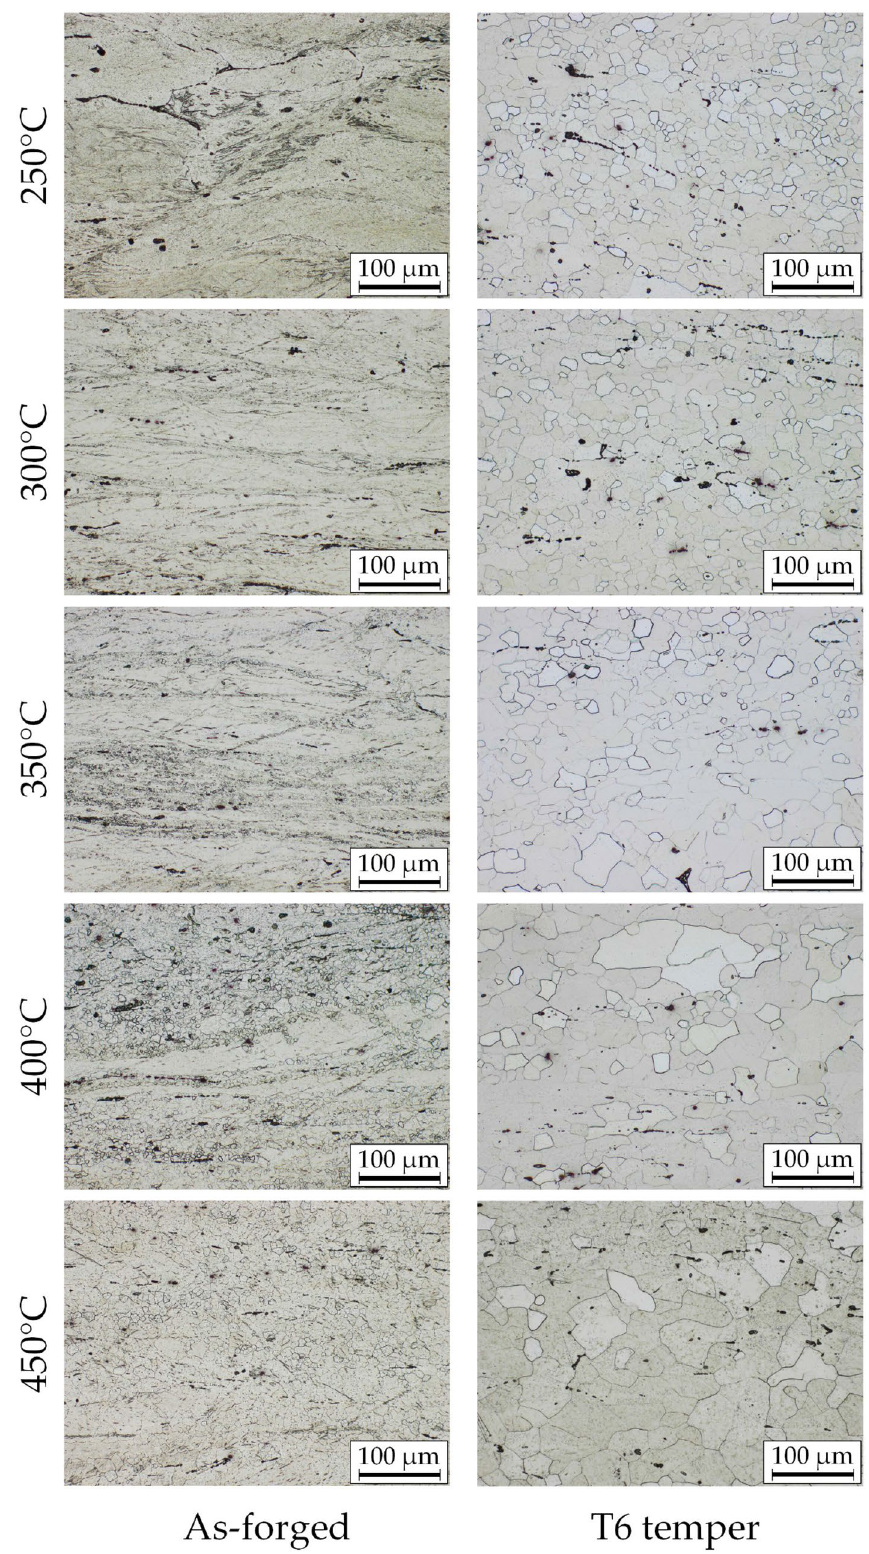
Fig. 6 OM images showing the microstructure of laboratory forged piston rods (part center) isothermally produced at 250 to 450 ◦ C . The images show as-forged as well as peak aged material